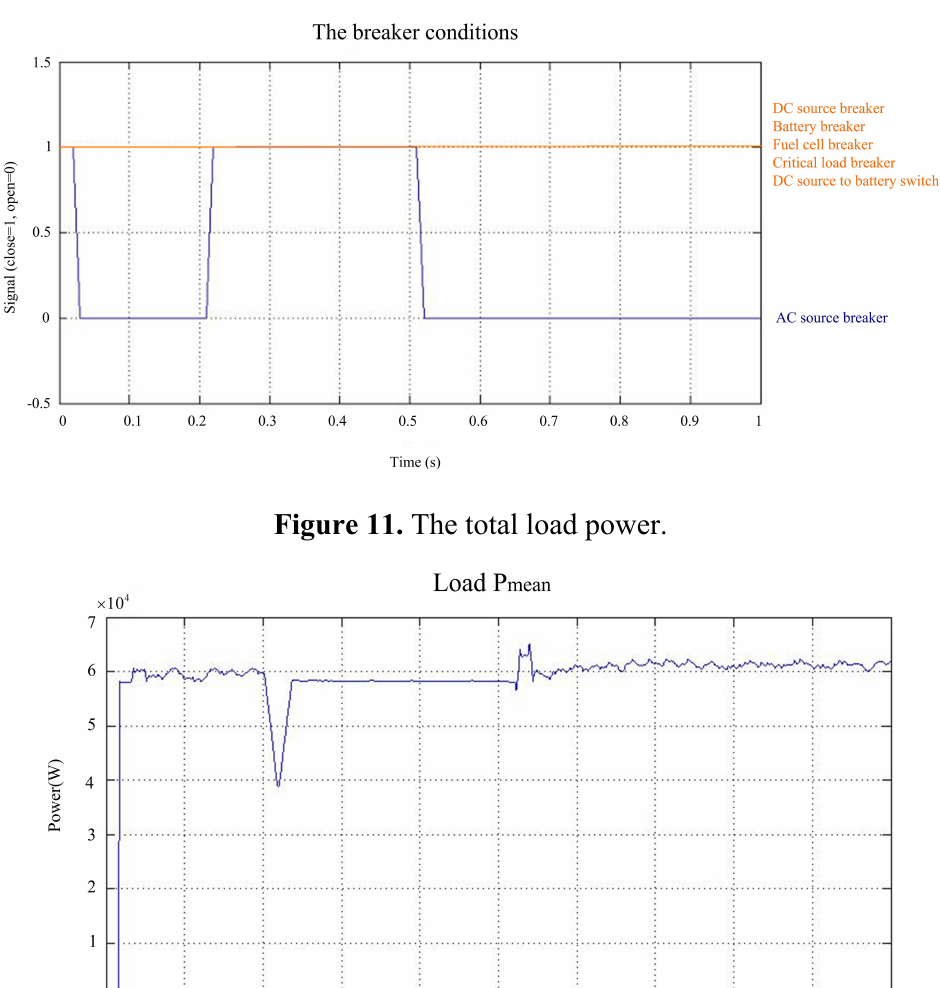
Figure 10. The breaker conditions.